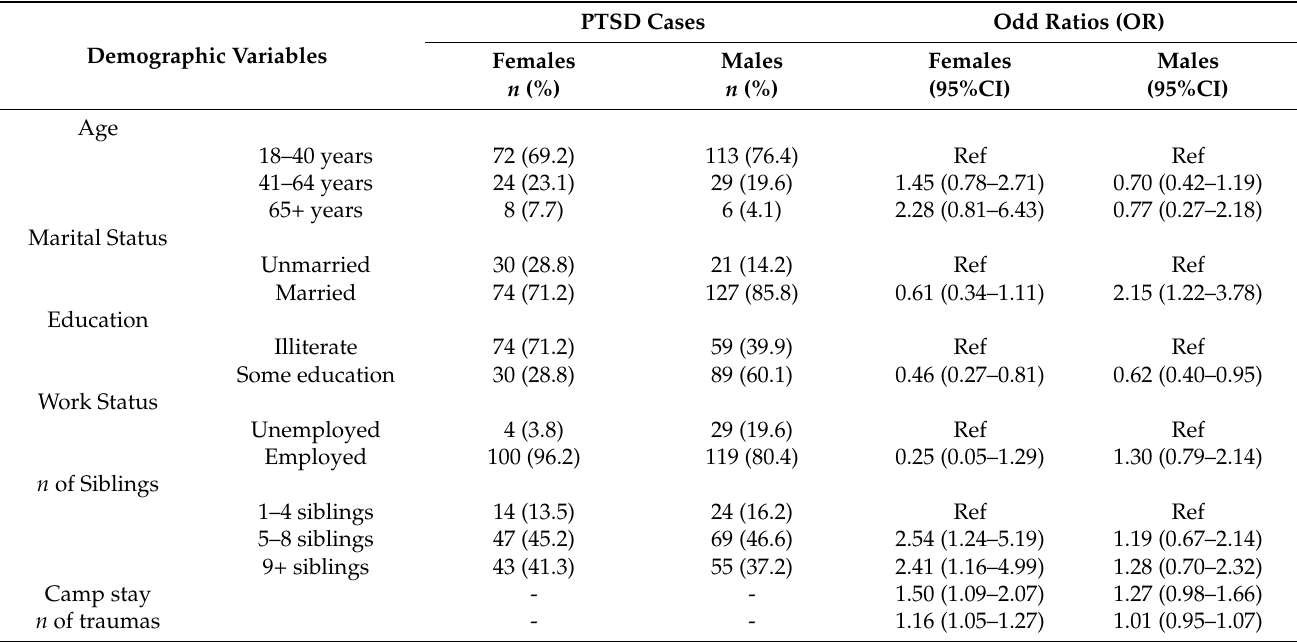
Table 4. Predictors of PTSD among male and female Iraqi